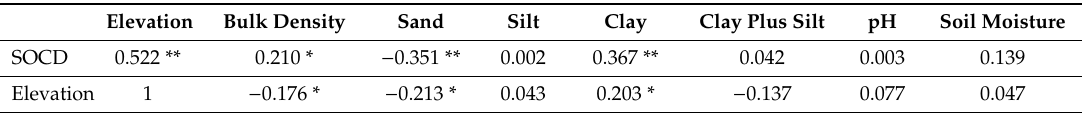
Table 2. Correlation matrix of soil properties, elevation and top soil organic carbon density (SOCD) at all sites ( n = 138).